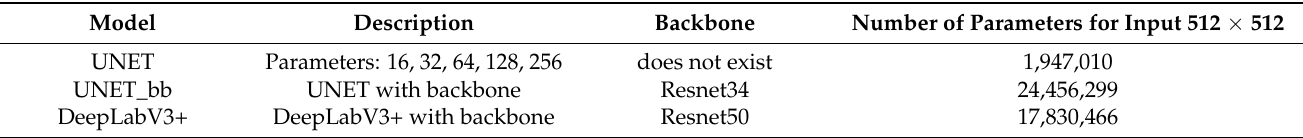
Table 2. Summary of used architectures.